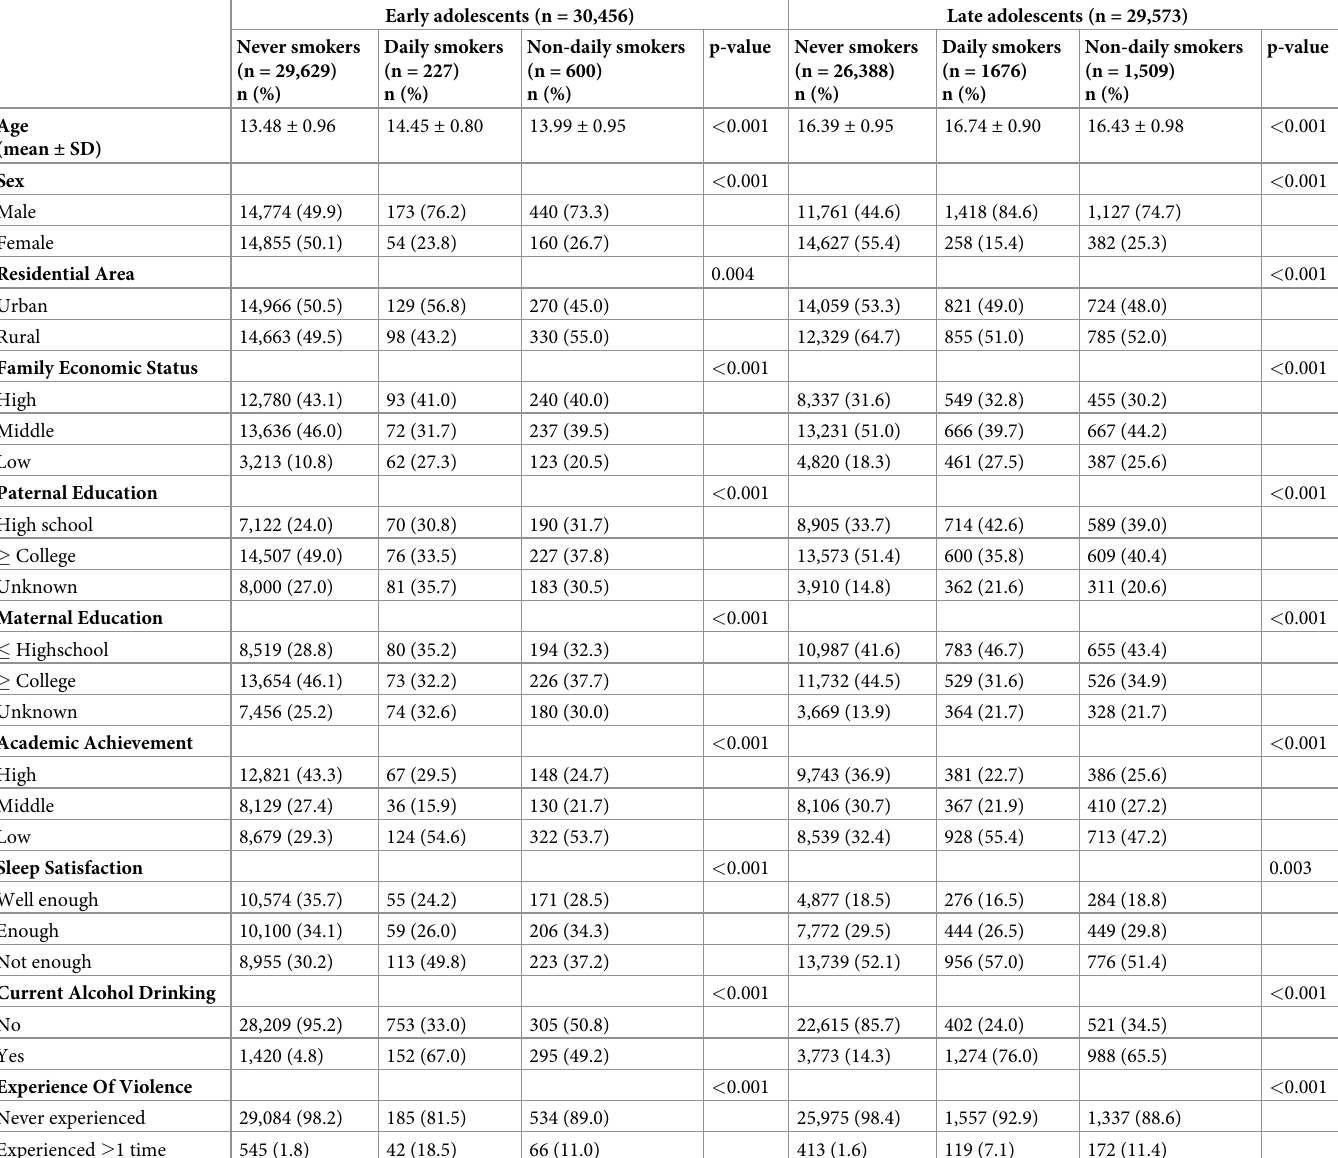
Table 1. Socio-demographic characteristics based on smoking patterns (KYRBS, 2016, Korean adolescents aged 12–18